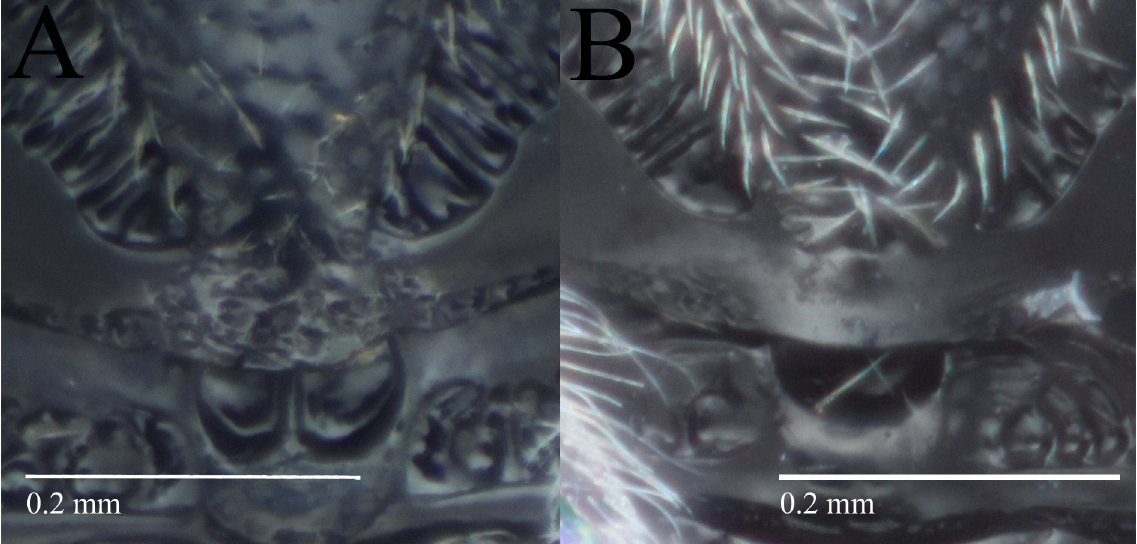
Fig. 9. A . Cotesia sp. nr icipe , medial posterior band of the scutellum (WINC, Cox Scrub). B . C. lasallei sp. nov., medial posterior band of the scutellum (holotype, SAMA 32-44401).